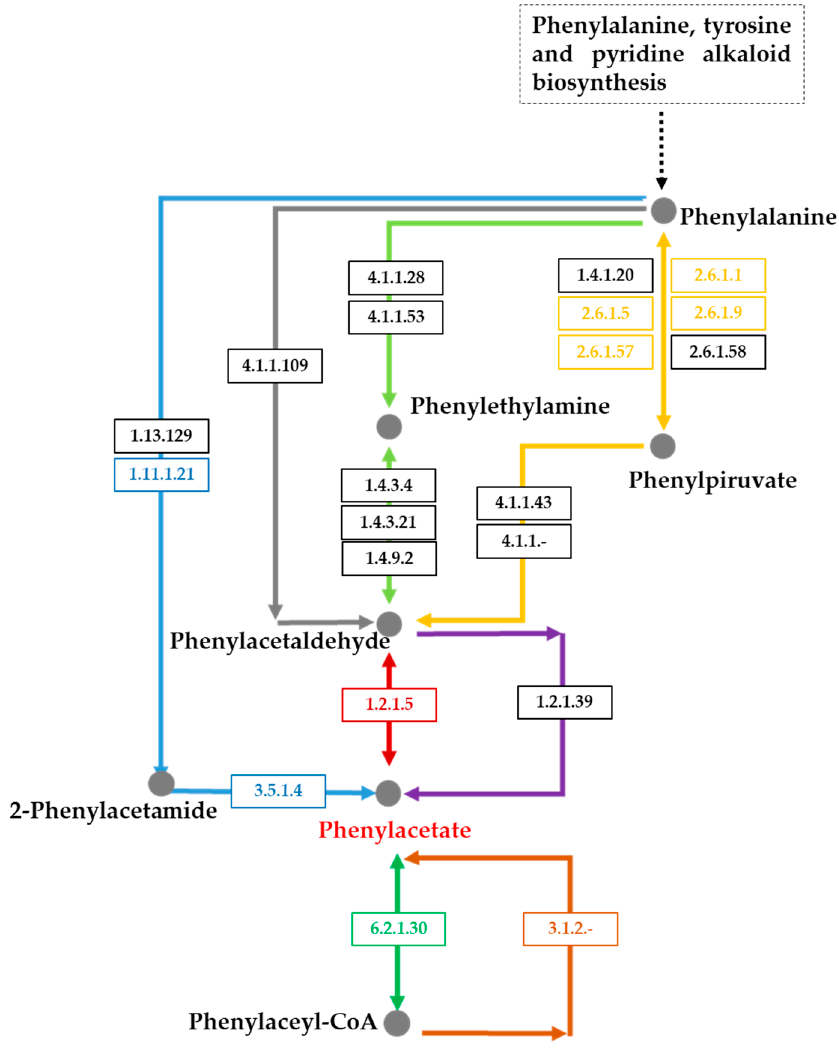
Figure 11. Phenylacetic acid (PhAc) biosynthesis from phenylalanine (Phe). In bacteria, PhAc is usually produced from Phe via the intermediate phenylpyruvate (PhePA). This route foresees transamination of Phe to PhePA (yellow arrow), which may undergo decarboxylation to phenylacetaldeide (PhAcld) and subsequent oxidation to PhAc (red arrow). Other biosynthetic ways, excluding formation of the intermediate PPA, foresee (a) decarboxylation of Phe to phenylethylamine (PheEA) (light green arrow), conversion to PhAcld and oxidation to PhAc, or (b) transformation into phenylacetamide (PhAcAM) (blue arrow), then converted to PhAc. Finally, enzymatic activation of PhAc to phenylacetyl-CoA is expected to be an important step to assemble succinic saccharide esters bearing a PhAc functional group. Colored boxes indicate enzymes involved in PhAc production that have been detected in the genome of Rhodococcus sp. I2R while dark boxes indicate enzymes that have not been identified.